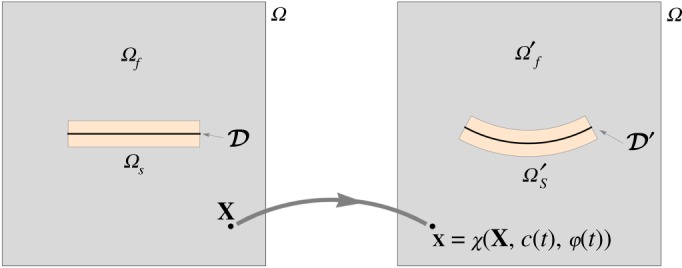
Structural (Ωs, Ωs′) and fluid (Ωf, Ωf′) domains in the reference and current configurations.